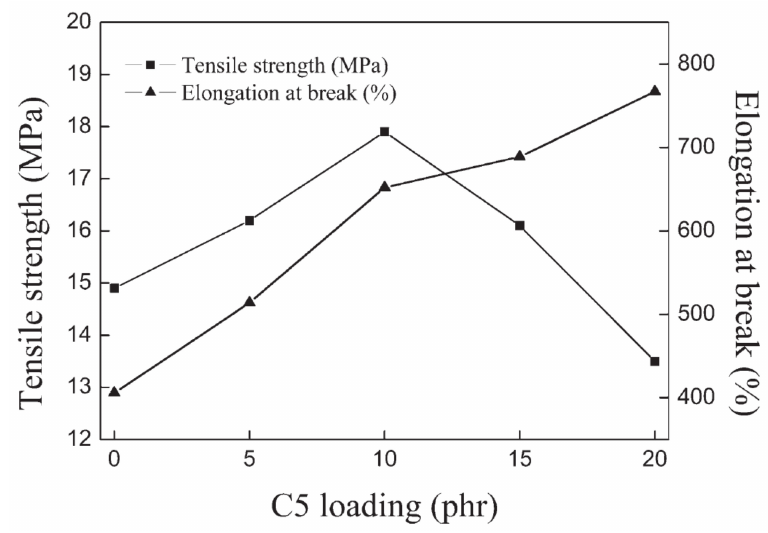
Figure 29. Tensile strength and elongation at break versus the loading of C5 resin for BIIR/BR/C5 vulcanizates [58].